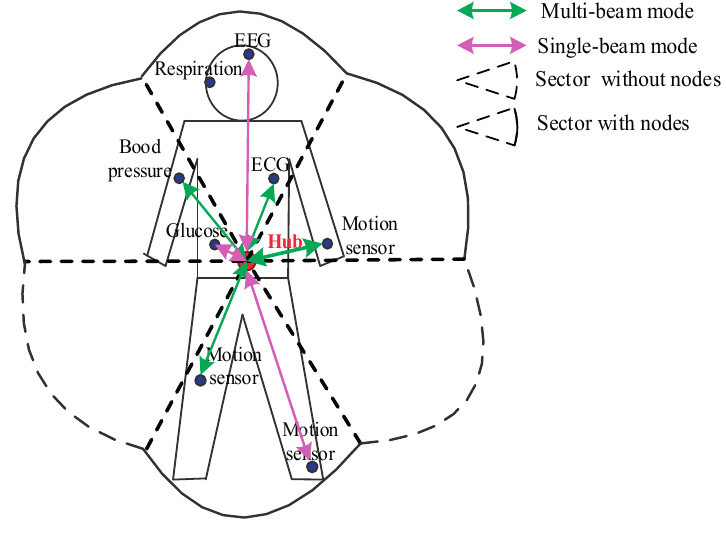
Figure 4. System model in wireless body area network.